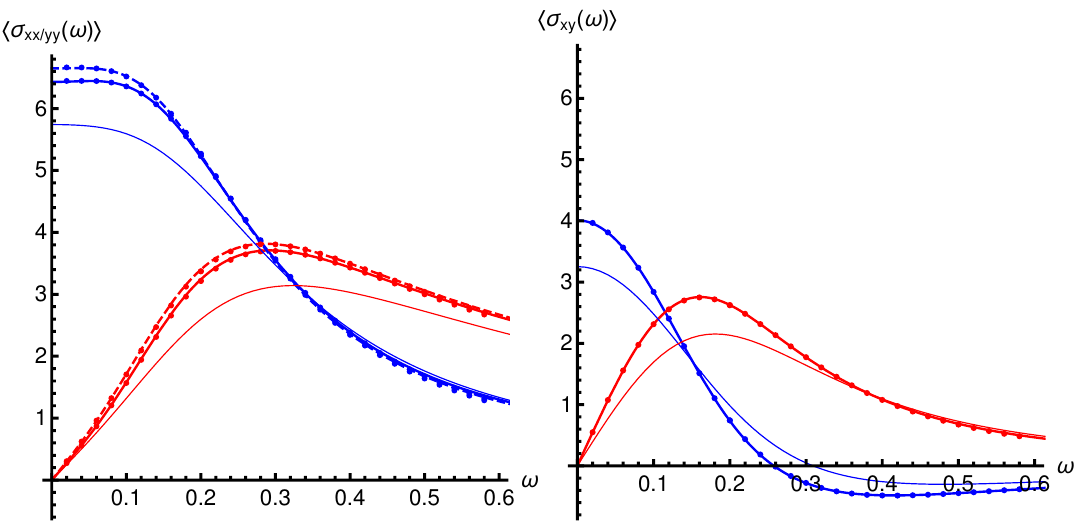
Figure 9 . The spatially-averaged longitudinal (left) and Hall (right) optical conductivities of the striped phase, fit to analytic formulas at b = 0 . 5 and µ = 4 , with the real parts shown in blue and the imaginary parts in red. Dots are the numerically computed data, and the curves show the fits. (left) The dashed curve is h σ xx i , and the solid is h σ yy i . (right) The solid curve is h σ xy i which is numerically equal to −h σ yx i . In both plots, the thin, solid curves are the analogous conductivities of the homogenous phase, shown for